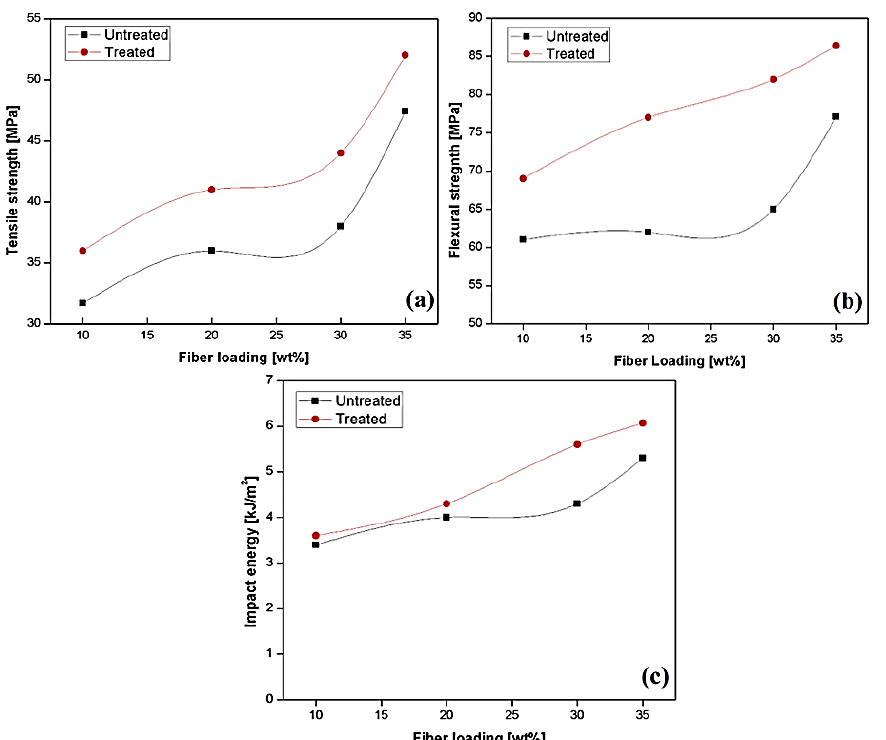
Figure 8. ( a ) Tensile ( b ) Flexural, and ( c ) Impact strength at fiber loading (10, 20, 30, and 35 wt. %) of untreated and 5 wt. % of alkali (NaOH)-treated sisal-reinforced epoxy composite. Adapted with the permission from Reference [72]. Copyright 2017, with permission from John Wiley and Sons.